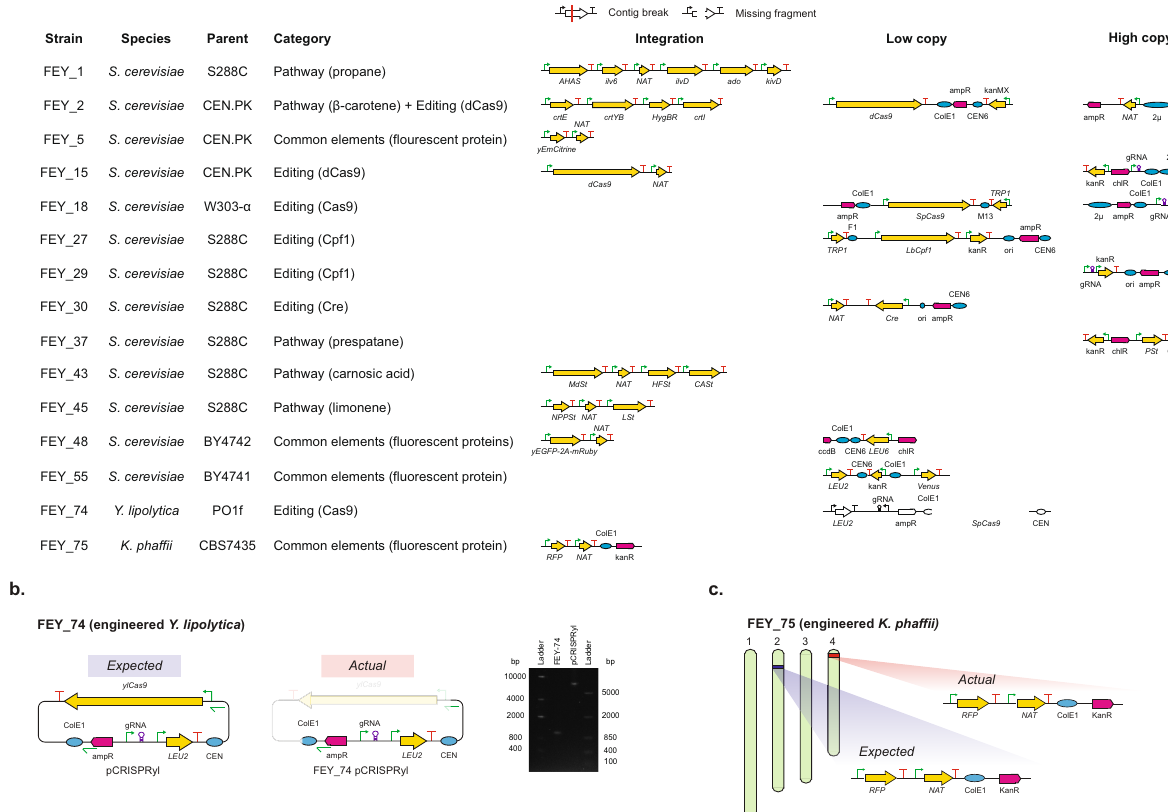
Fig. 2 Resolving signatures of engineering from the panel of engineered yeast strains. a Visual representation of the BLASTN results from querying known engineering signatures against Prymetime-assembled genome assemblies of the 15 engineered strains. Failure modes of genome assemblies were shown as red lines (contig break) and white spaces (missing fragment). The colored pathways and plasmids represent assemblies where all engineering signatures were found in contiguous sequences. b The expected CRISPR-Cas9 expression vector for FEY_74, an engineered Y. lipolytica strain, and the actual plasmid from the Prymetime genome assembly. The DNA agarose gel con fi rms the missing Cas9 cassette from the FEY_74 strain in comparison to the original pCRISPRyl plasmid. The agarose gel represents one experiment, where the PCR products of the pCRISPRyl plasmid and FEY_74 plasmid were processed in parallel. c Illustration showing the expected location of the RFP integration cassette into chromosome II of FEY_75, an engineered K. phaf fi i strain, and the actual location of the cassette into chromosome